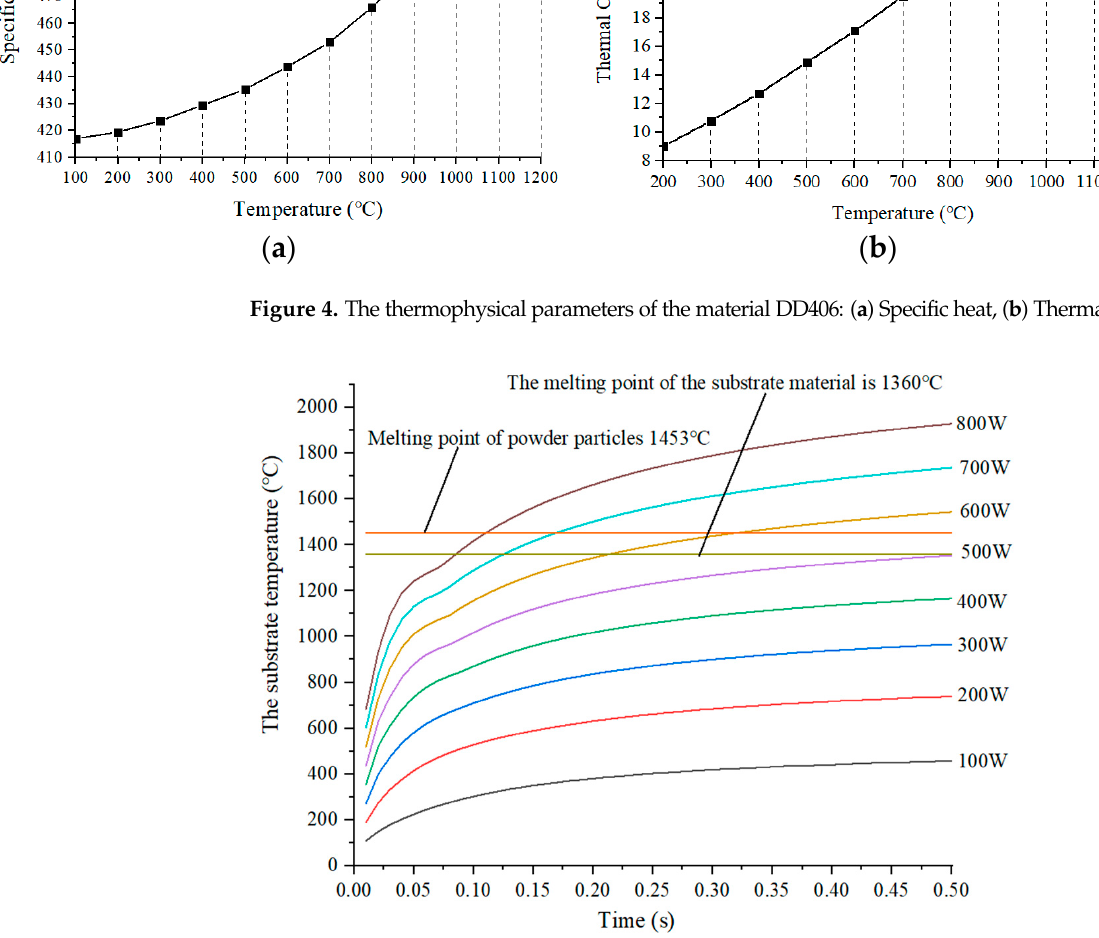
Figure 5. The relationship curve between the substrate temperature and the time.